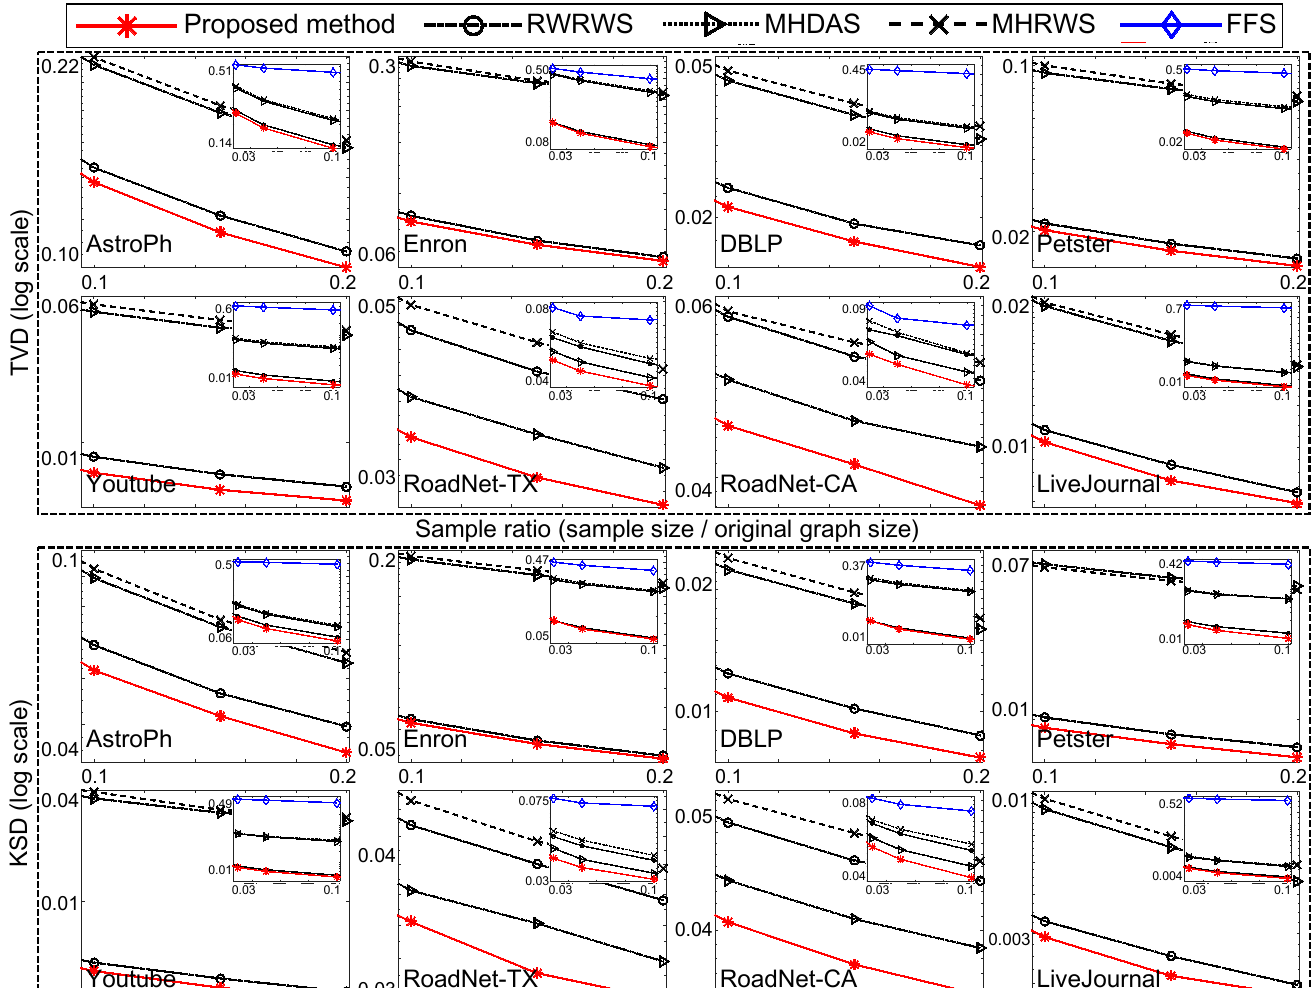
Figure 7. Comparison of proposed and well-known network sampling methods relative to node